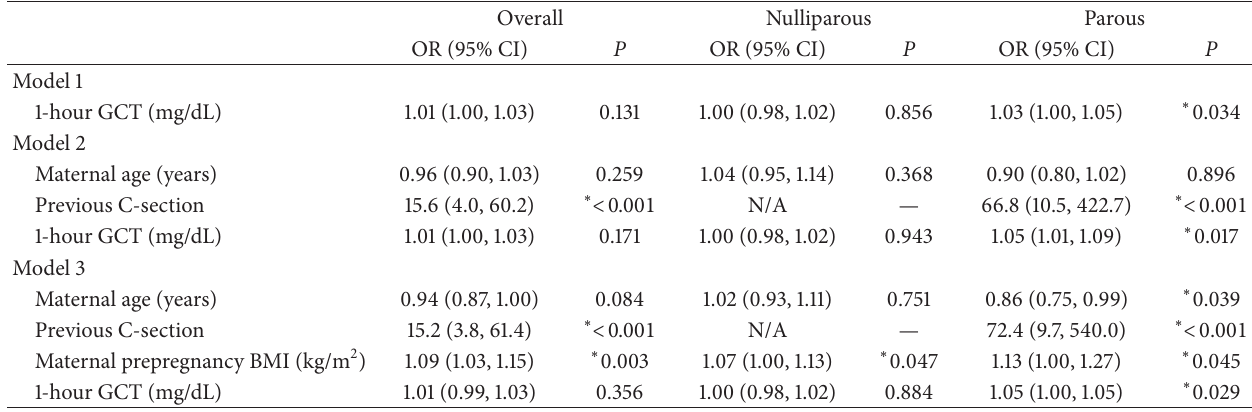
Figure 1: (a) Correlation of 1-hour glucose challenge test (1hr GCT) value with maternal age at study visit. (b) Correlation of 1-hour glucose challenge test (1hr GCT) value with maternal prepregnancy BMI. Table 2: Association between continuous 1-hour GCT values and delivery by C-section, compared to vaginal delivery, in the overall sample, and stratified by